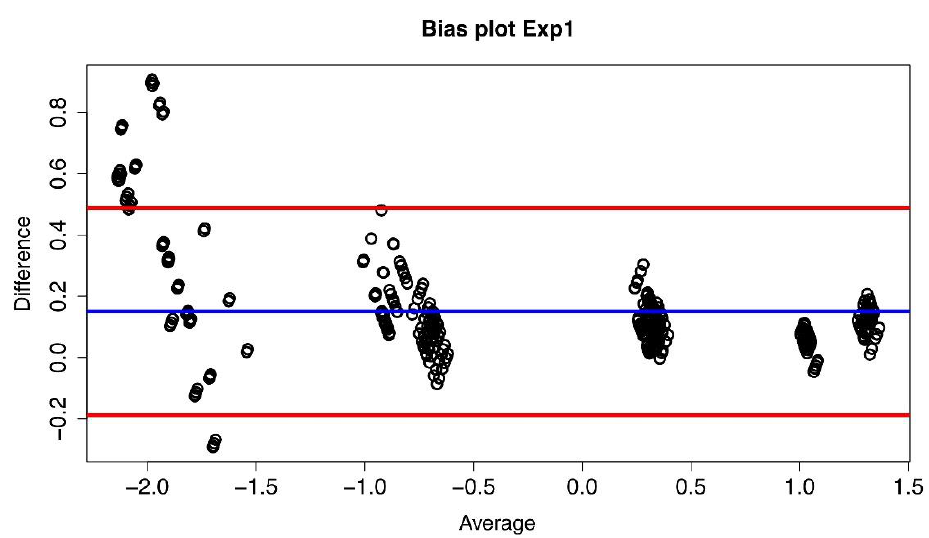
Figure 2. Bias plot of Lab1/Lab2 for Exp1. The difference between the two corresponding datasets are plotted versus their average value. The blue line represents the mean value of thedifferences (d) (where each difference is defined as log 10 (B) − log 10 (A)), and the red lines define the 95% limits of agreement.